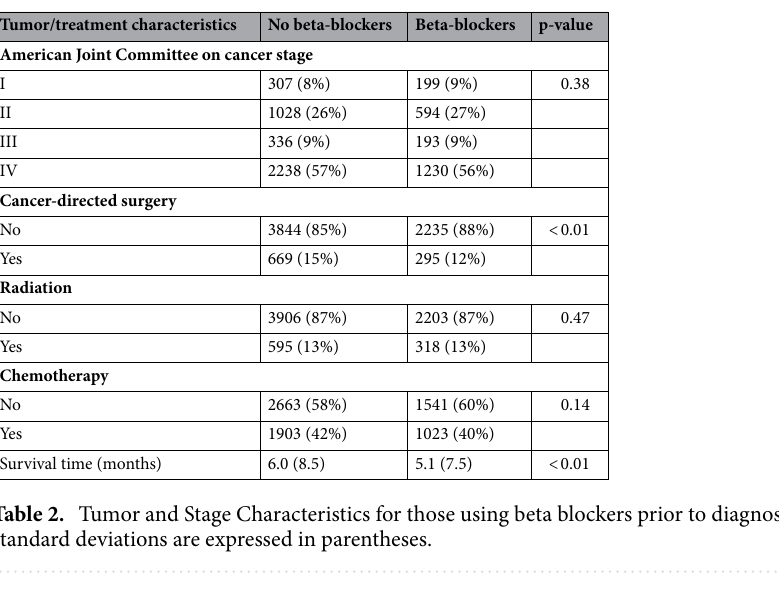
Tumor/treatment